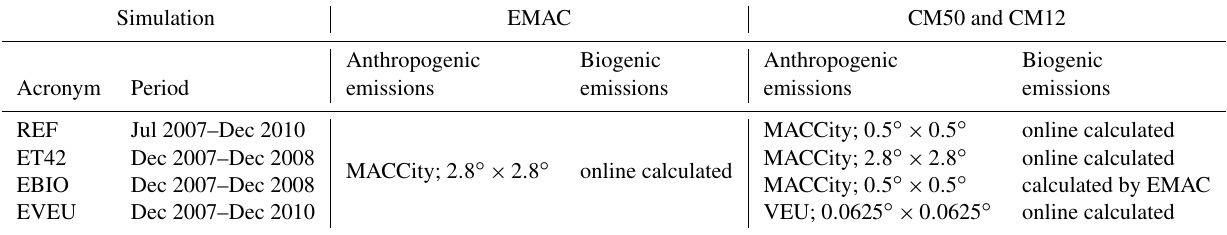
Table 2. Overview of the applied MECO(2) simulation set-ups and simulation periods. For the EMAC instance the same set-up is applied in all simulations, but the set-ups of the COSMO-CLM/MESSy instances (CM50 and CM12) are varied systematically. More details are given in the text. The note “calculated by EMAC” in the row “biogenic emissions” means that the emissions, which are calculated by EMAC, are transformed to the COSMO-CLM grid during runtime via the MMD2WAY submodel.